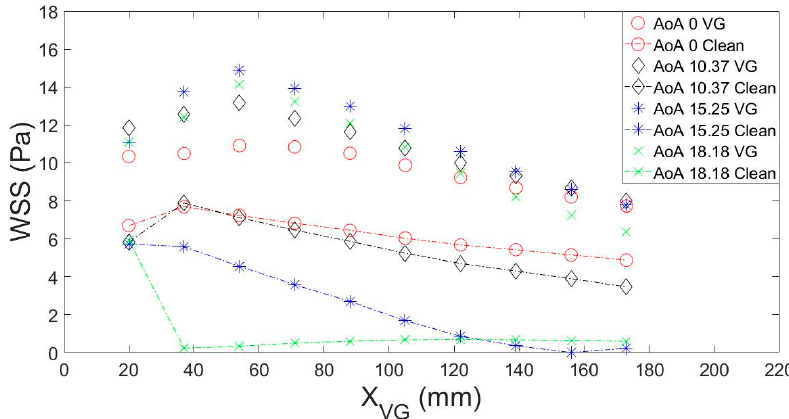
ff erent angles of attack Figure 10. Wall shear stress values for different angles of attack (AoAs). Figure 10. Wall shear stress values for di Figure 10. Wall shear stress values for different angles of attack (AoAs).